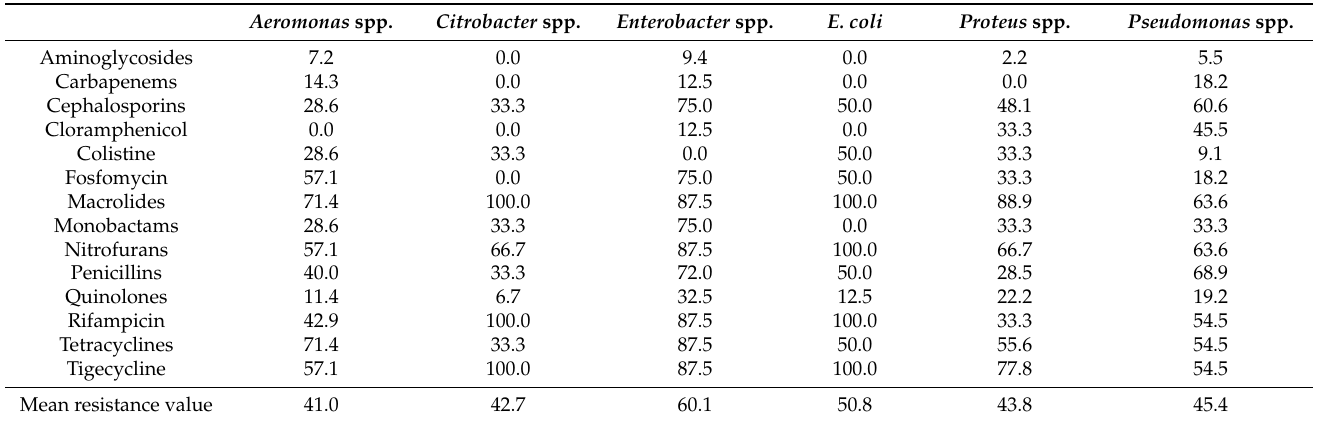
Table 1. Percentage resistance levels of the detected genera to the antibiotic families used.